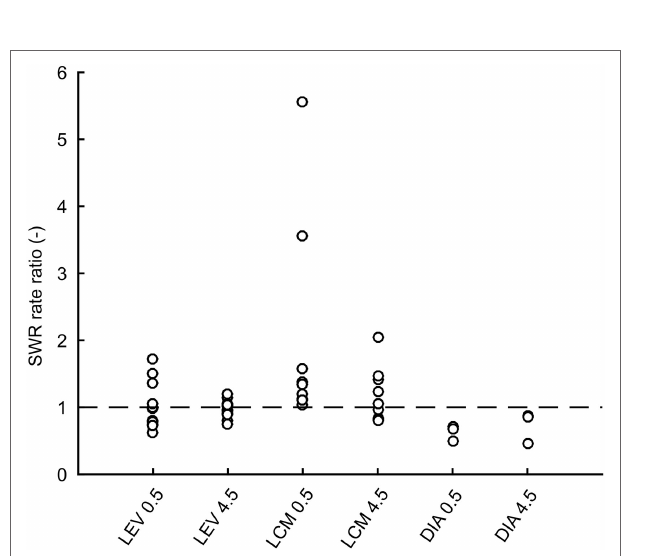
FigUre 3 | Ratios of sharp-wave ripple (SWR) rates after drug treatment to rates after saline treatment for individual rats. Dashed line is at value 1 which constitutes no effect. LEV, levetiracetam; LCM, lacosamide; DIA, diazepam; CtrlXXX, injection of an equivalent volume of saline; 0.5, half an hour after injection; 4.5, four and half hours after injection.